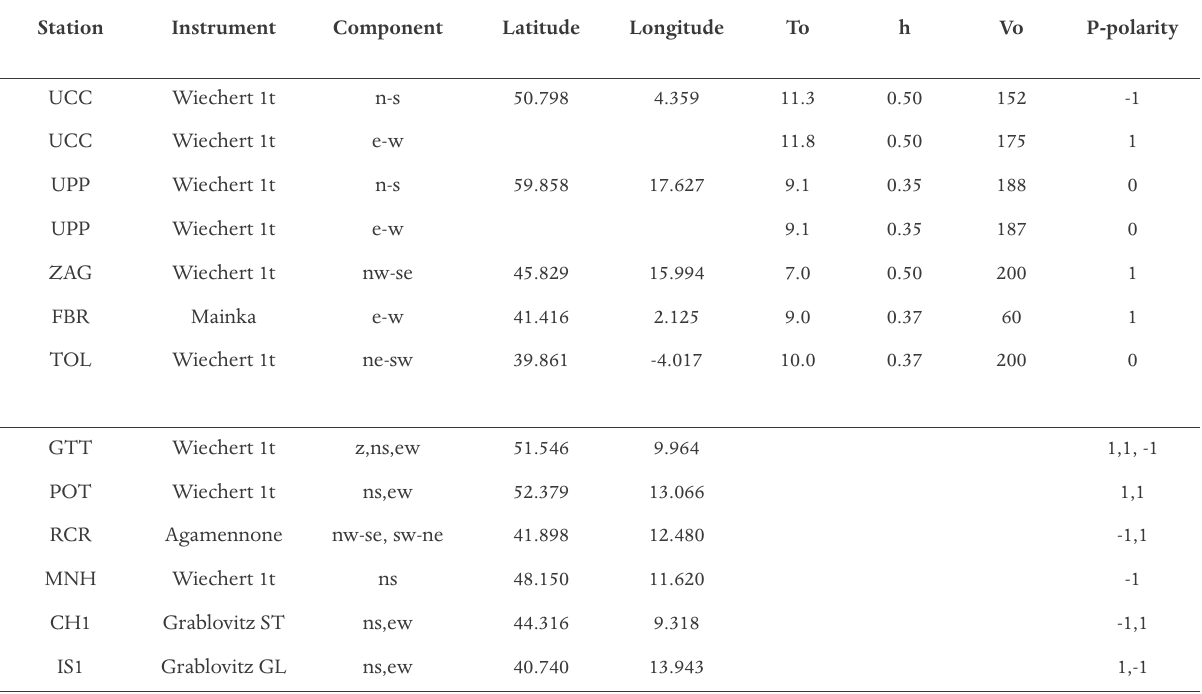
Table 4. Data used for the power spectra computation and MT estimation. Top: latitude, longitude, instrument type, instrument re- sponse parameters and polarities for each station and instrument component used for power spectra computation. Bottom: additional polarities used to constrain the T- and P- axes. Polarities include polarity of the first P-arrival and of the instrument. Polarity equal to 0 are not used. Instrument: Agamennone = Agamennone horizontal pendula seismograph; Grablovitz GL = Grablovitz geodynamic pen- dula; Grablovitz ST = Grablovitz seismic tank; Mainka = Mainka horizontal seismograph; Wiechert 1t = 1 ton Wiechert horizontal seis-